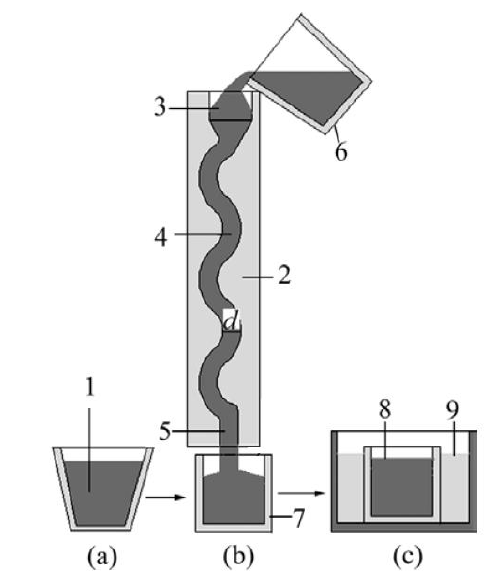
Fig. 2 Schematic diagram of preparing semi-solid ZL101 aluminum alloy slurry by serpentine channel: (a) Melt; (b) Preparation of semi-solid slurry; (c) Cooling. 1—K-type thermocouple; 2—Serpentine channel; 3—Pouring cup; 4—Serpentine bend; 5—Diversion